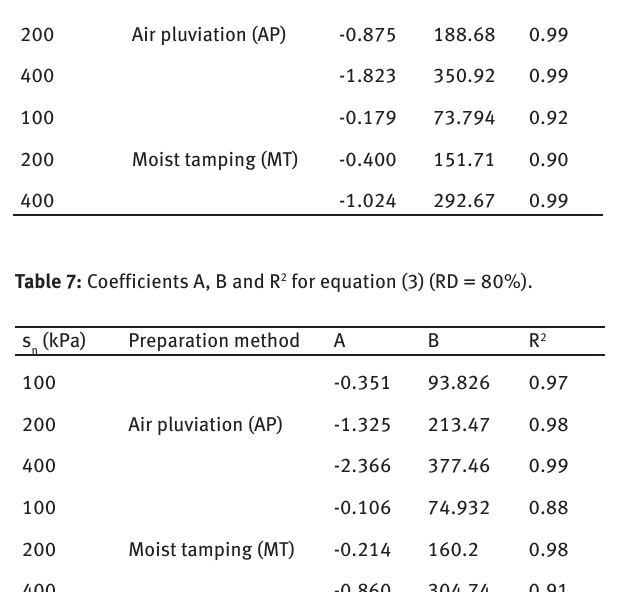
Table 6: Coefficients A, B and R 2 for equation (3) (RD = 65%). s (kPa) n